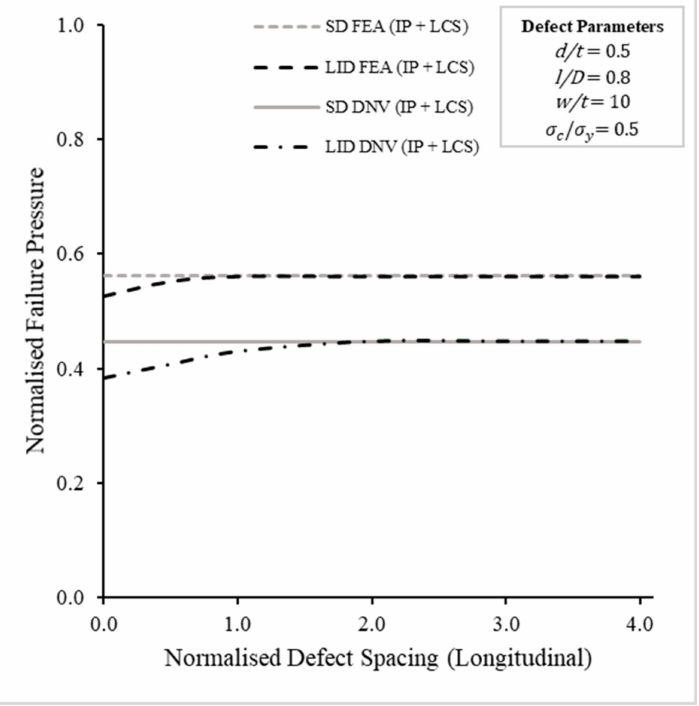
Figure 8. FEA and DNV predictions of normalised failure pressure predictions versus normalised longitudinal defect